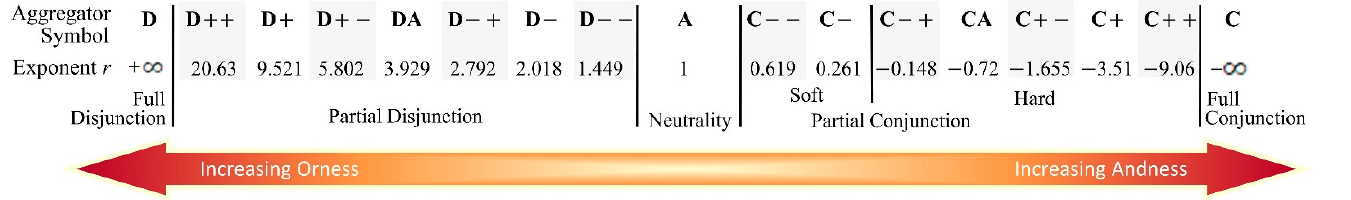
Figure 1. Logic scoring of preference (LSP) logic aggregators with associated symbols and r exponent values.